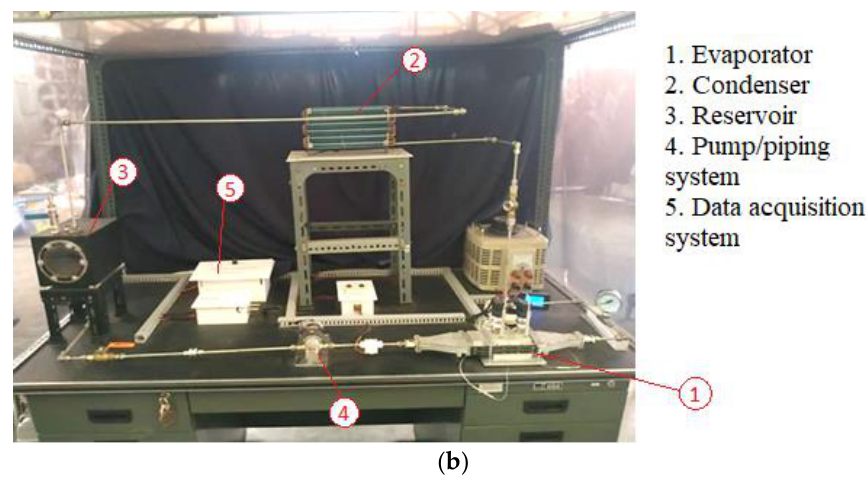
Figure 1. Experimental facility by ( a ) schematic diagram and ( b ) system configuration.